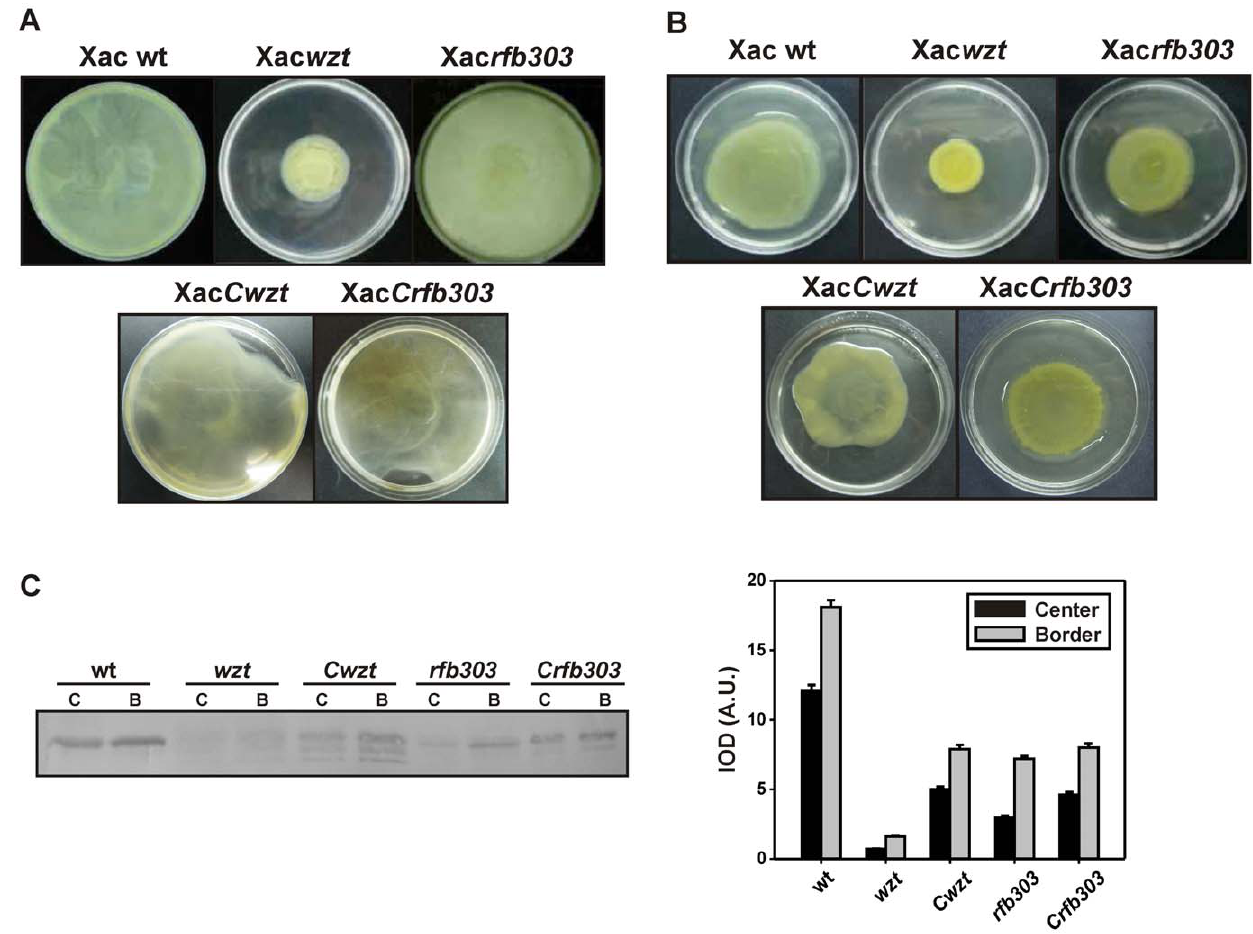
Figure 3. Bacterial motility assays. The different strains were centrally inoculated on SB plates supplemented with 0.3% (w v 2 1 ) agar for swimming (A) and 0.7% (w v 2 1 ) agar for swarming assay (B) and incubated 4 days at 28 u C to determine migration zones. (C) Analysis of flagellin expression of bacteria from the border and the center of swarming plates by Western Blot using Serratia marcescens anti-flagellin rabbit polyclonal antibodies (left panel). Expression profiles were obtained by densitometric quantification of band intensities (right panel). Experiments were performed in triplicate with similar results; bars indicate mean 6 standard deviation. IOD, integrated optical density; A.U., arbitrary units; C: center and B: border zone of a swarming plate.